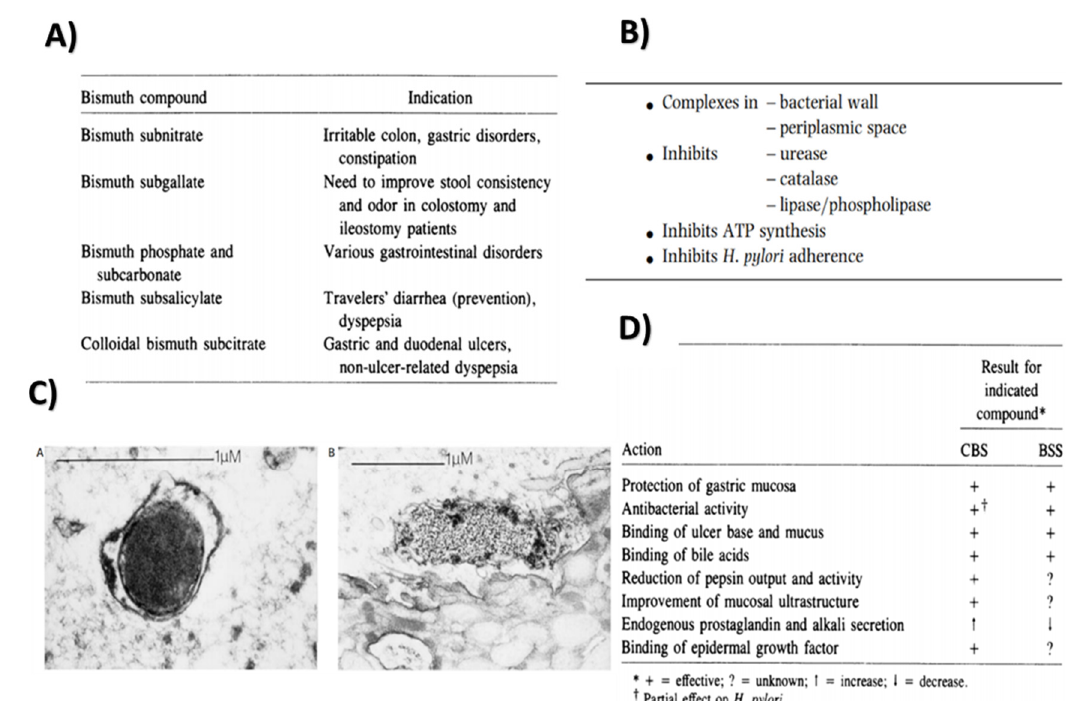
Figure 3. ( A ) Use of bismuth salts over the years. Adopted from [42]. Reproduced with permission from Oxford University Press. ( B ) Bactericidal mechanism of bismuth. ( C ) Left side ( A ) shows H-pylori after 120 min of bismuth action depicting detachment of bacterial cell walls and with vacuolization; the right image ( B ) shows structural degradation in and on the surface of H-pylori . ( D ) Therapeutic effects of different bismuth compounds on the body. Adapted from [56]. Reproduced with permission from Wiley/Blackwell.